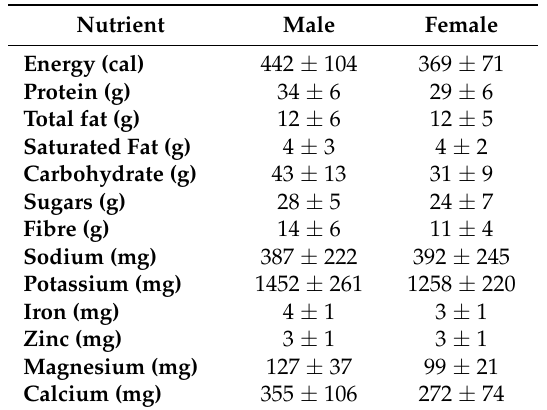
Table 2. Dietary analysis of weight food checklists from restricted days (mean ±